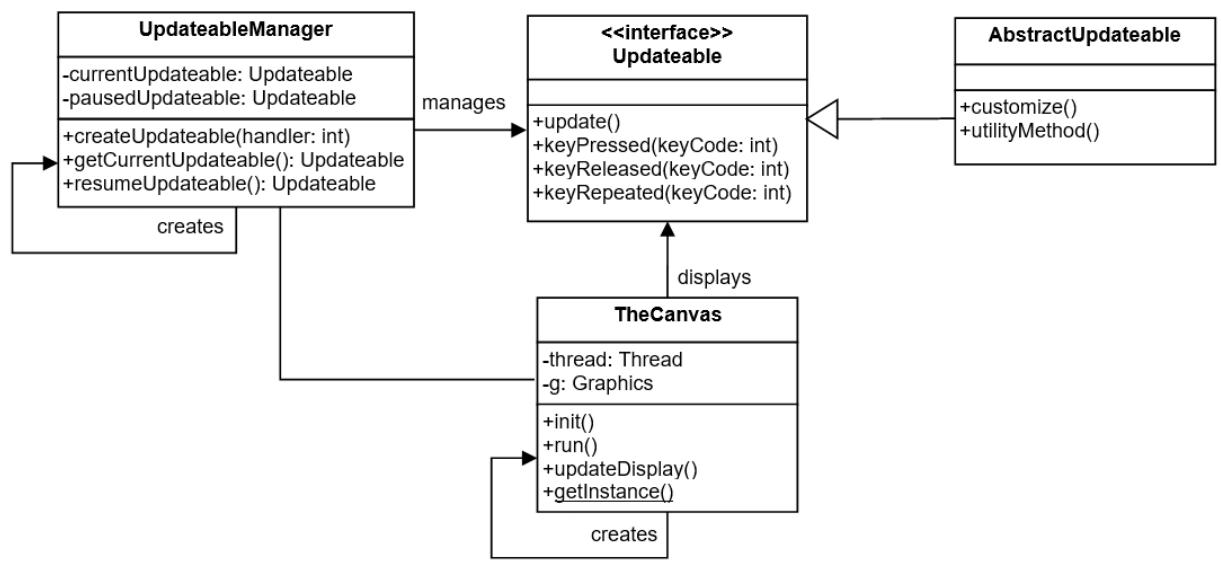
Figure 10. Common classes for all